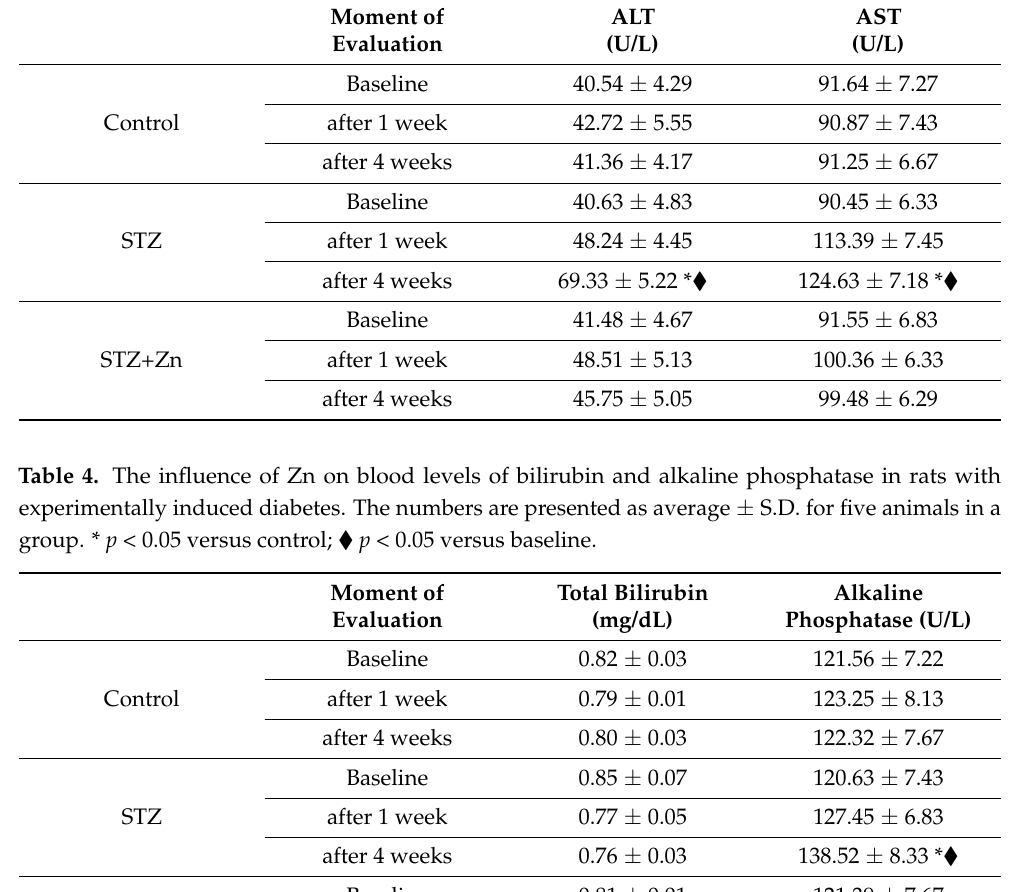
Table 3. The influence of Zn on ALT and AST activity in diabetic rats. The numbers are presented as mean value ± S.D. for five animals in a group. (ALT—alanine-aminotransferase, AST—aspartate- aminotransferase) * p < 0.05 versus control; (cid:7) p < 0.05 versus baseline.